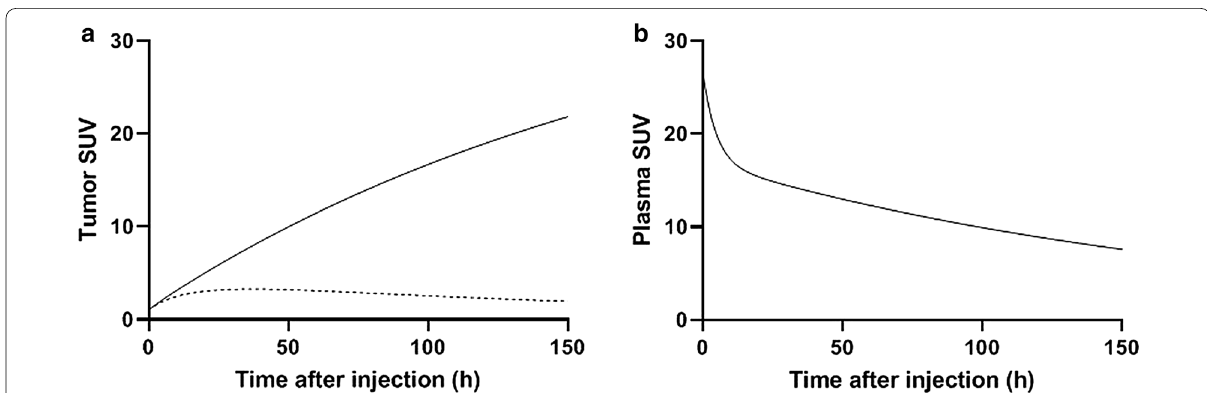
Fig. 3 Tumor uptake (calculated) and plasma PK (from literature) of 50 mg 89 Zr‑trastuzumab as a function of time. Tumor uptake ( a ) for a tumor without target expression (dashed line) and a clinically HER2‑positive tumor (IHC3) (solid line). Plasma PK ( b )